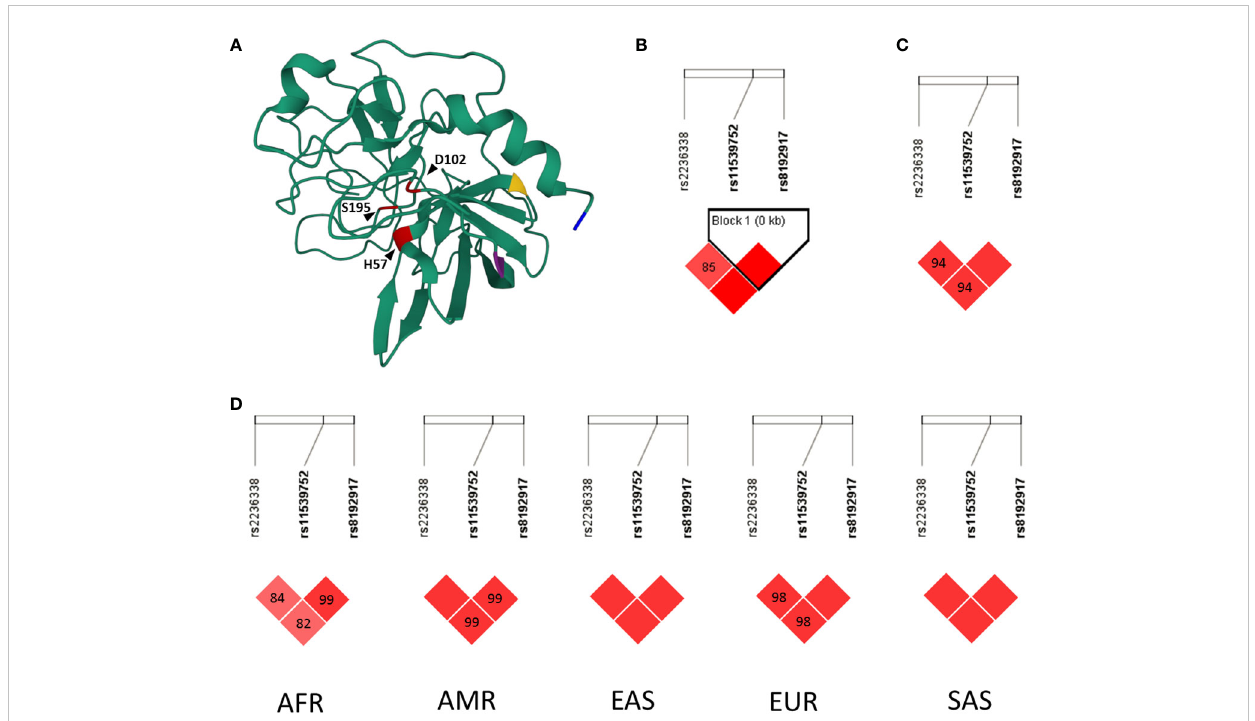
FIGURE 1 Structural representation and linkage disequilibrium analyses of rs2236338, rs11539752 and rs8192917 of GZMB Panel (A) : 3D visualization of the crystallographic structure of Granzyme (B) Members of the catalytic triad are highlighted in red (H57, D102, S195). Amino acids altered by rs8192917, rs11539752 and rs2236338 are highlighted in yellow (Q48R), purple (P88A) and blue (Y245H), respectively. 3D protein structure (1FQ3) was deposited to Protein Data Bank (rcsb.org) by Estebanez-Perpina et al. (23) and was visualized using Mol* Viewer (24). Panels (B – D) : Linkage disequilibrium (LD) analyses of SNPs rs2236338, rs11539752 and rs8192917. Haploview 4.2 was used for LD analysis of the Hungarian WES cohort (Panel B ). LDMatrix online tool of the LDLink package was used to analyze LD in the CEU (Utah residents from North and West Europe) population (Panel C ) and in additional populations (Panel D ). The D ’ values of each SNP pair are indicated within the squares in the matrices. Solid red squares indicate D ’ value of 100%. D ’ values characterize the extent two which two alleles are nonrandomly associated (25). A D ’ value of 100% between two SNPs corresponds to fully dependent inheritance, while a D ’ value of 0% signals that the inheritance of the two SNPs are statistically independent from each other. AF, African; AMR, Ad Mixed American; EAS, East Asian; EUR, European; SAS, South